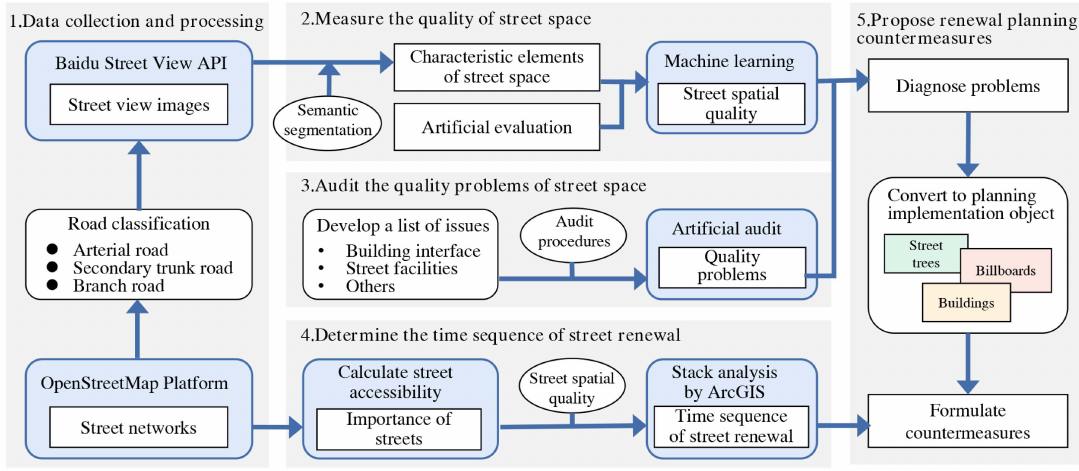
Figure 1. Analytical